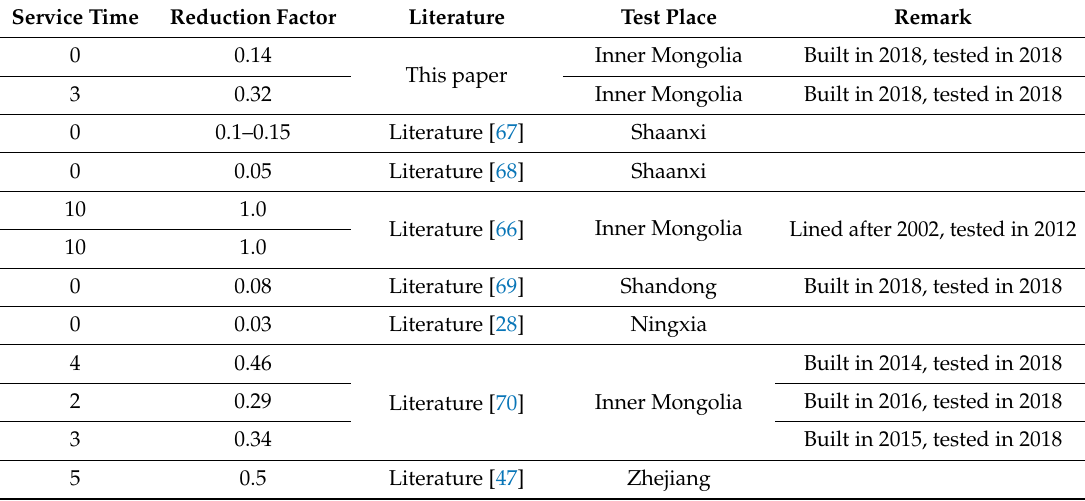
Table 4. Statistical results of lining reduction factor in China from